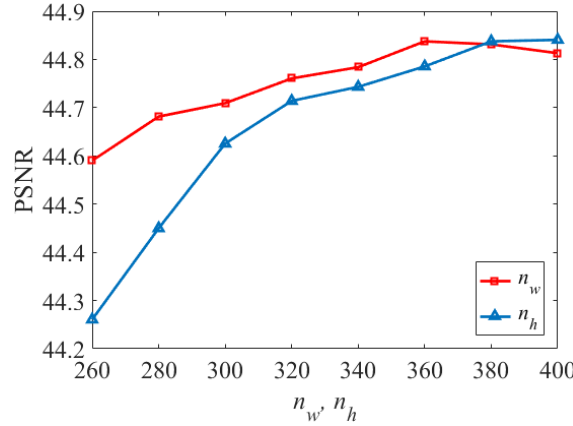
Figure 7. PSNR values for different n w and n h .